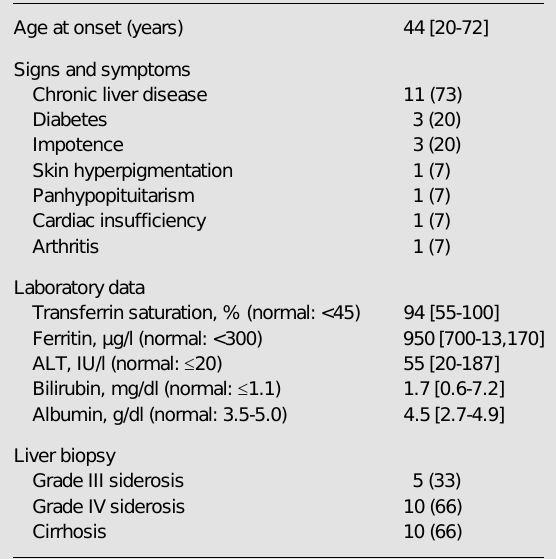
Table 1. Clinical and laboratory features of 15 Brazilian patients with hemochromatosis. Age at onset